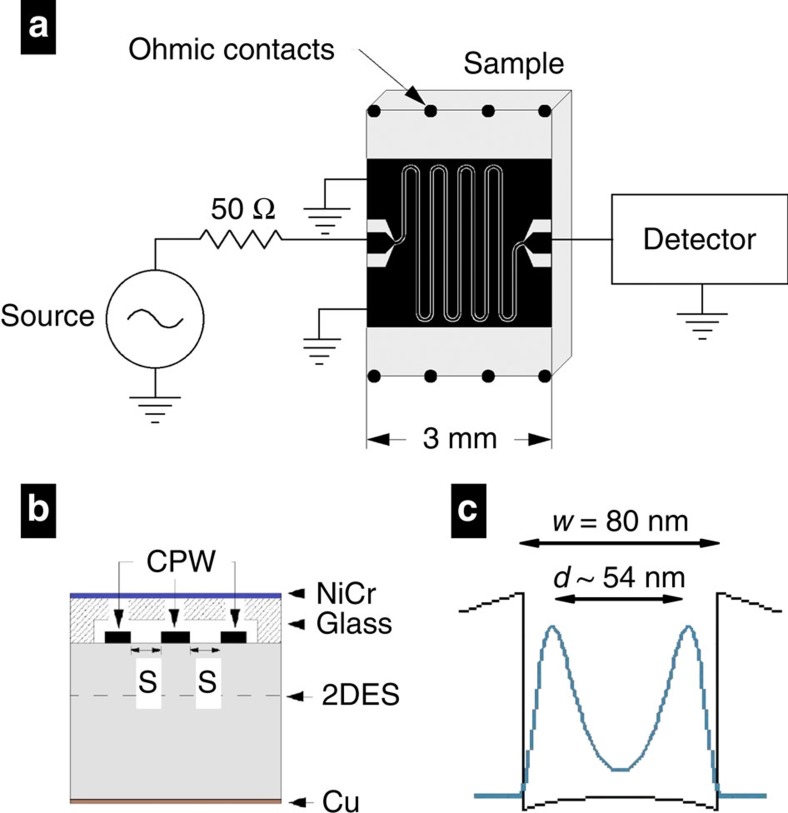
Schematic of sample for microwave measurement.(a) Schematic of the microwave measurement set-up. The source and detector are outside the cryostat at room temperature and the coplanar waveguide transmission line is patterned in metal film on top of the sample surface. The microwave conductivity σxx is calculated from loss through the line. (b) The microwave set-up shown in a cutaway side view. Slots of width s separate the centre, driven conductor and the ground planes. (c) The growth-direction electron charge distribution for a well of width w=80 nm at n=1.26 × 1011 cm−2 obtained from one-dimensional simulations. The growth-direction separation of charge density peaks is ∼54 nm.